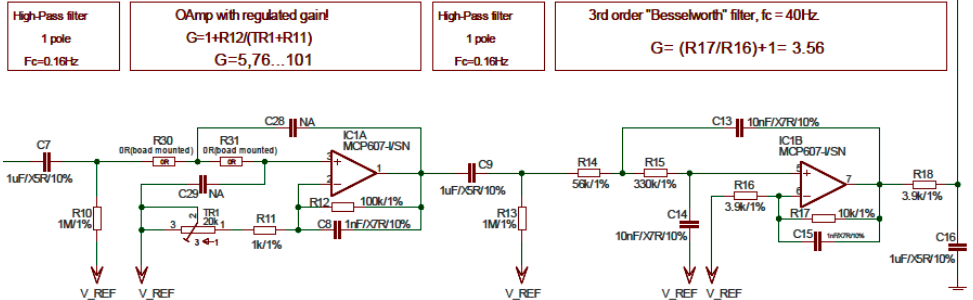
Figure 2. Schematics of single-ended amplifier (after the instrument amplifier) on the Olimex ECG/EMG shield (image from Olimex ECG/EMG shield manual) before modification.